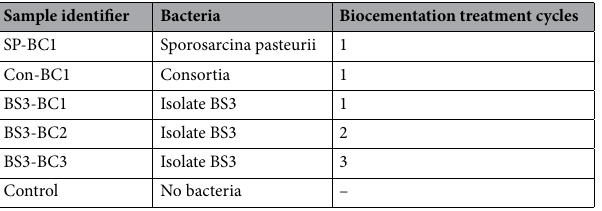
Table 3. Details of soil samples